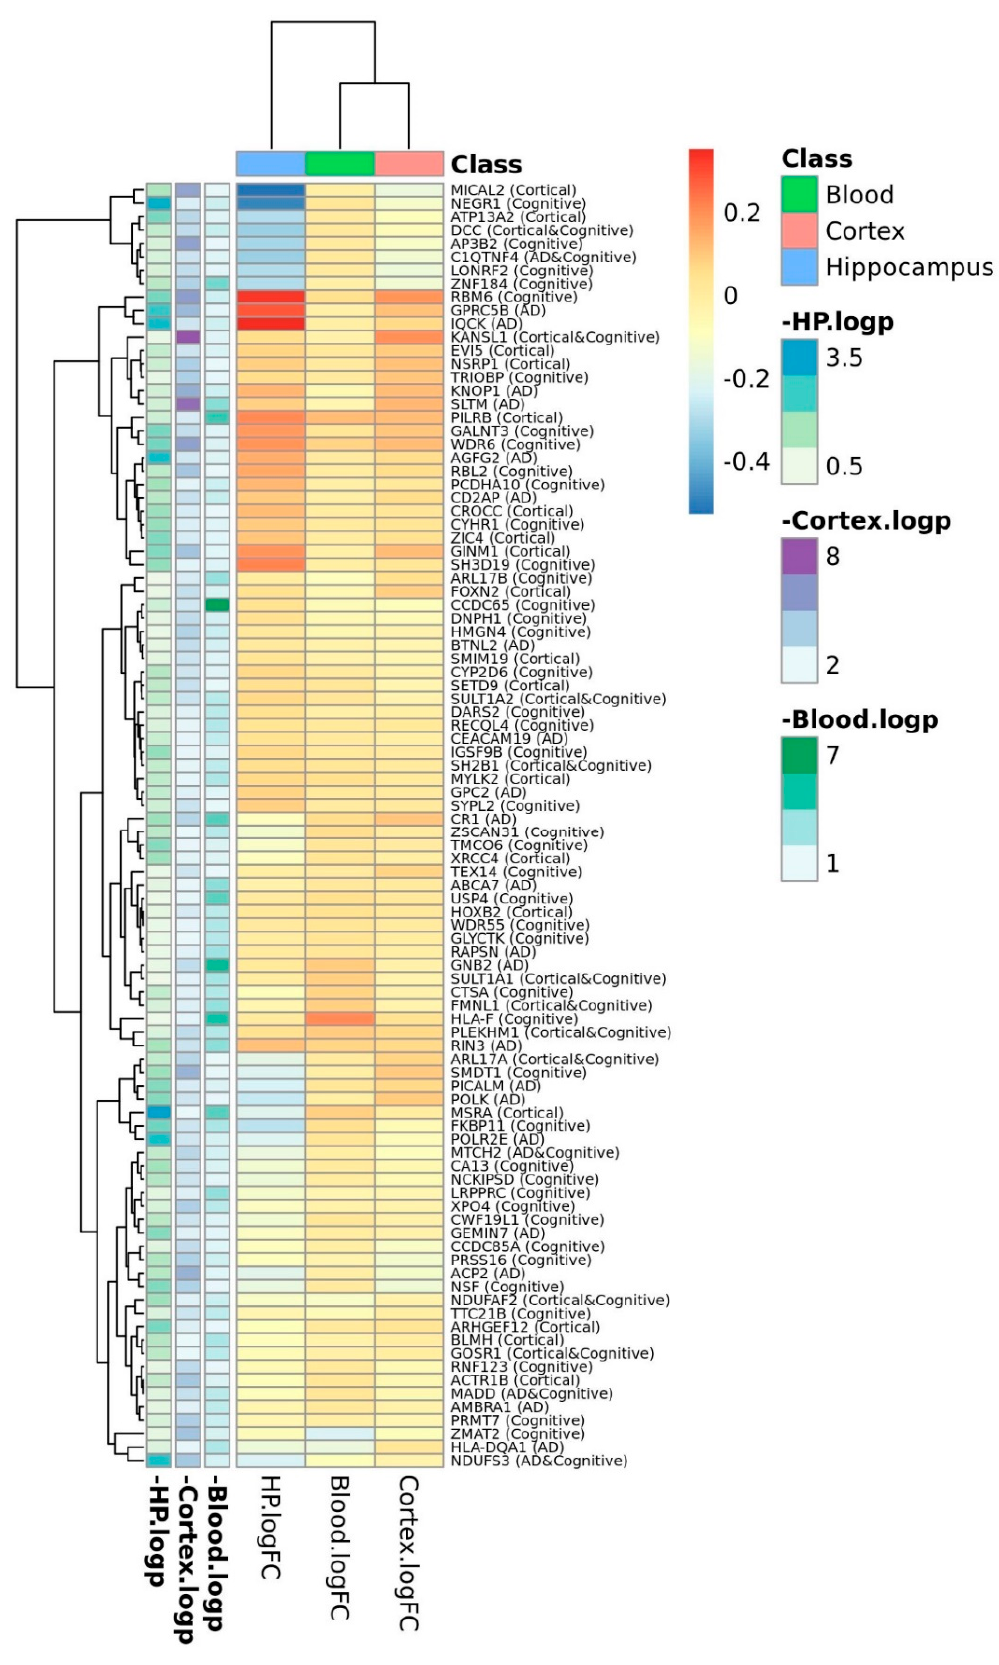
Figure 2. Heatmap plot of logFC expression values between AD cases and controls at the mRNA level.